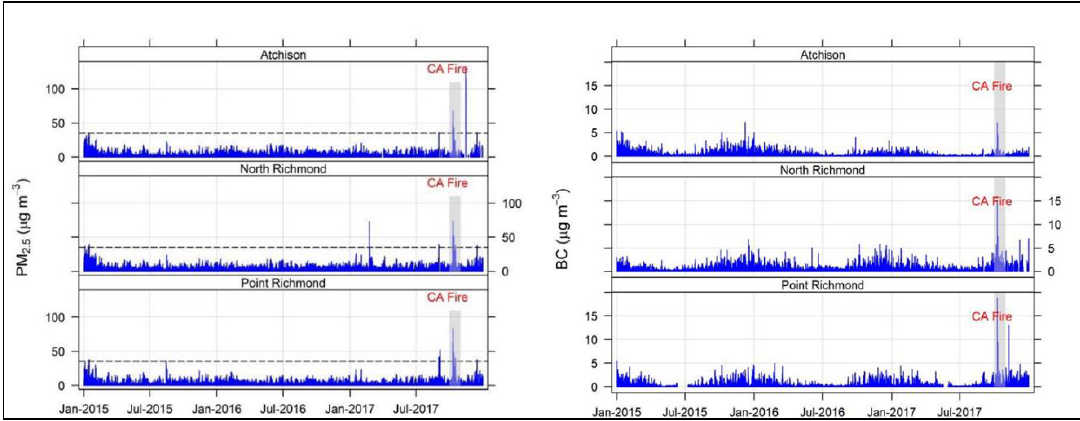
Figure 5. BC 1-h average concentration and PM 2.5 24-h concentration along with the 24-h PM 2.5 NAAQS (shown as dashed line) at the three community monitoring stations, including Point Richmond, North Richmond and Atchison Village. Gray bars indicate periods of enhanced PM 2.5 and BC concentrations likely associated with the Northern California wildfire [46]. Non-detect data (below a detection of 6 and 0.01 µg/m 3 for PM 2.5 and BC, respectively) were replaced with one-half the detection limit (3 and 0.005 µg/m 3 for PM 2.5 and BC, respectively).